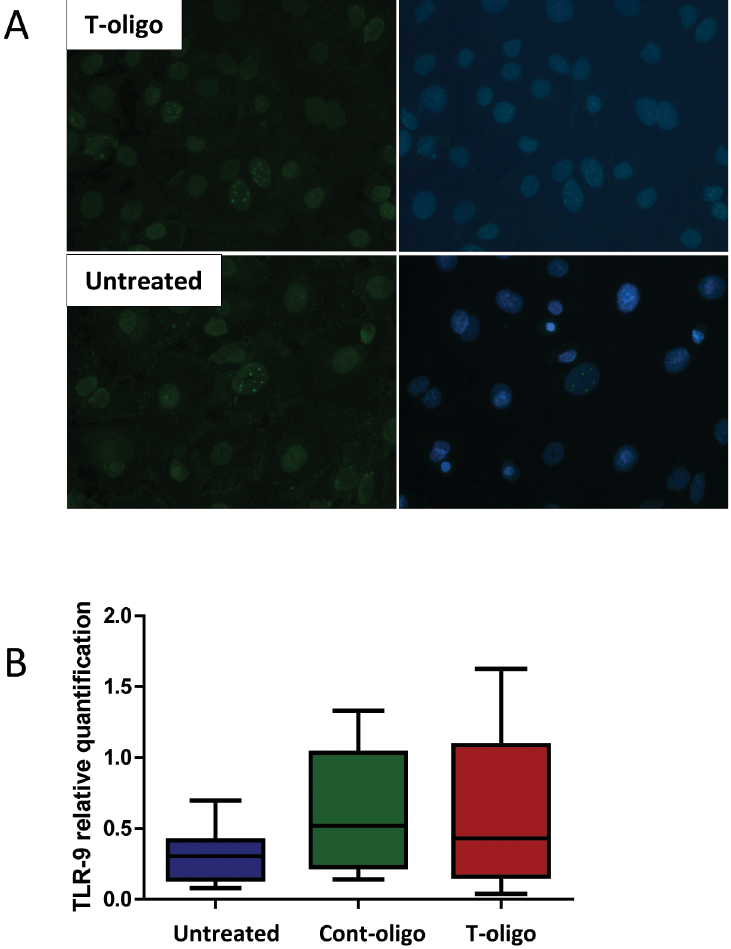
Top panel = T-oligo treated amnion cells, bottom panel = untreated cells. Left panel = γ H2AX. Right panel = merged images with DAPI nuclear stain. The bright nuclear dots represent DNA damage foci and are more pronounced in cells treated with T-oligo. (B) Relative quantification of TLR-9 mRNA expression in amnion cells in the studied groups, untreated cells, Cont-oligo and T-oligo treated cells, respectively. Box plots represent the quantification relative to endogenous 16S RNA. Kruskal-Wallis test, p > 0.05.(control oligonucleotides (Cont-oligo, [AATCCC] 2 ); Telomere mimetic overhang sequence (T-oligo, [TTAGGG] 2